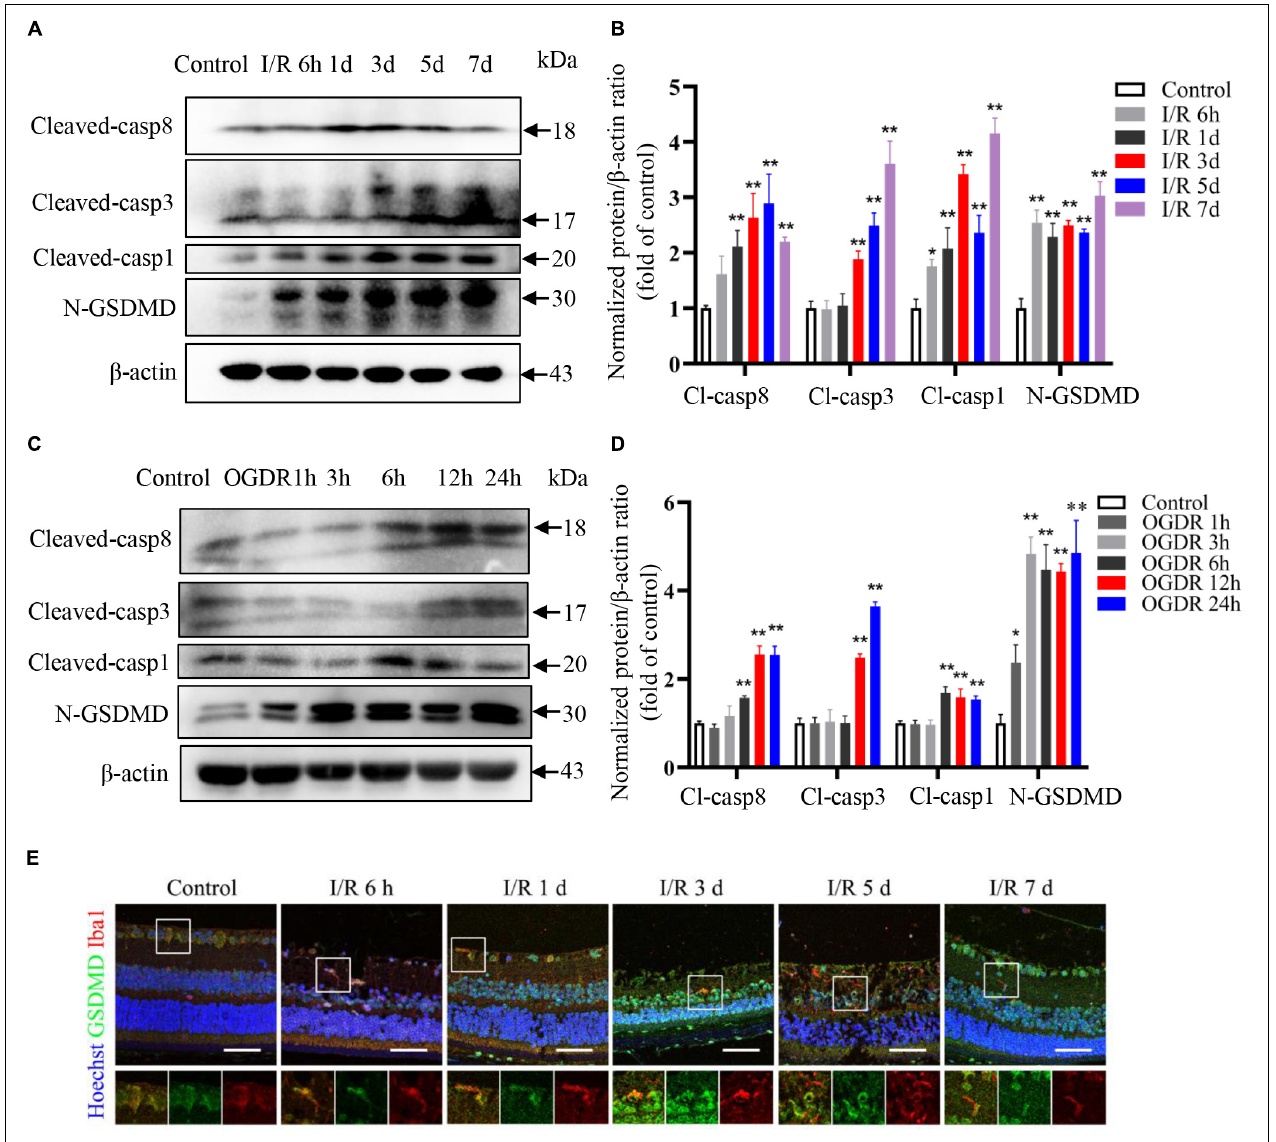
FIGURE 3 | Pyroptosis and apoptosis are induced sequentially by ischemia–reperfusion in retina and cultured microglia. (A,B) Western blot analysis showing induction of pyroptosis and apoptosis markers in retinal tissue following RIR ( n = 3). (C,D) Western blot analysis showing upregulation of pyroptosis and apoptosis markers in BV2 microglia following OGDR ( n = 3). (E) Dual immunofluorescence staining of retina showing induction of the pyroptosis markers GSDMD in retinal microglia following RIR (Scale bar: 50 µ m, Magnification: × 400). I/R, retinal ischemia–reperfusion; OGDR, oxygen-glucose deprivation and reperfusion. * P <